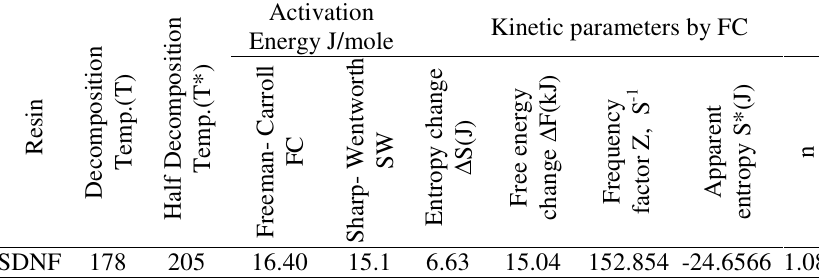
Table 2. Result of thermogravimetric analysis of SDNF terpolymer